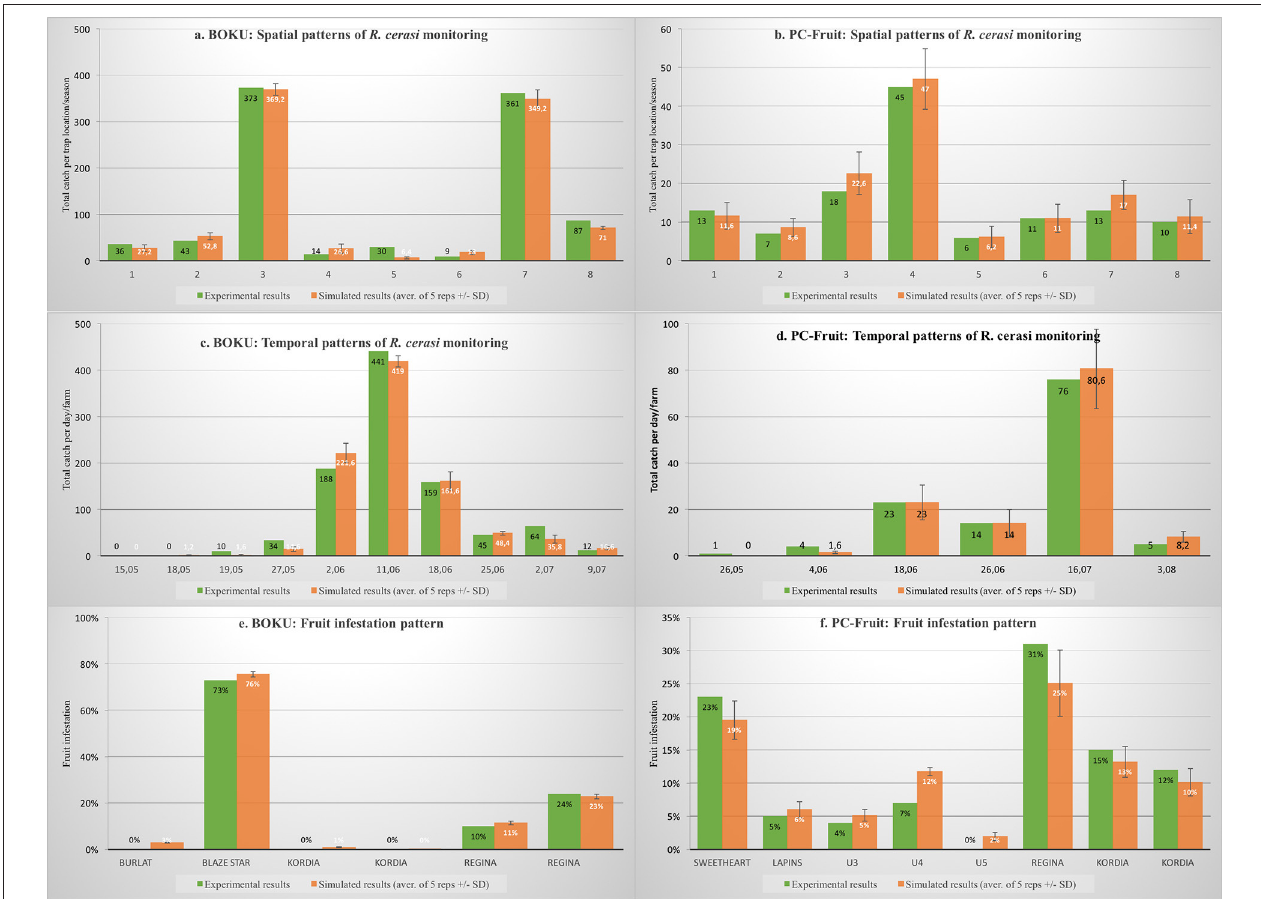
TABLE 4 | Comparison between pest monitoring and fruit infestation patterns: experimental vs. model-generated. Source data Figure 3A . BOKU: spatial pattern of pest monitoring Figure 3C . BOKU: temporal pattern of pest monitoring Figure 3B . PC-Fruit: spatial pattern of pest monitoring Figure 3D . PC-Fruit: temporal pattern of pest monitoring Figure 3E . BOKU: fruit infestation pattern Figure 3F . PC-Fruit: fruit infestation